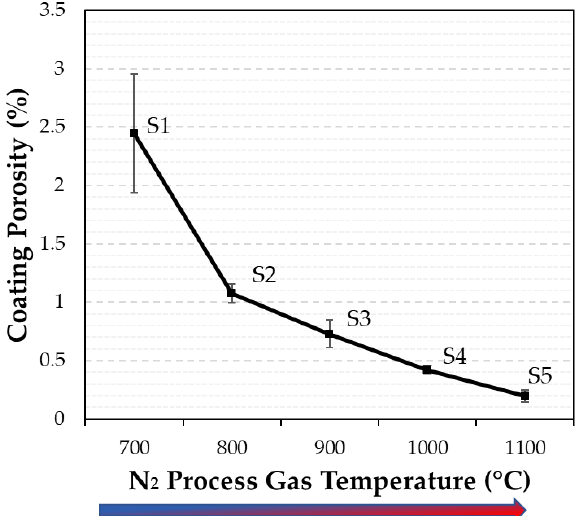
Figure 7. Porosities of the CS Zr coatings (S1–S5) with respect to N 2 process gas temperature (varied between 700−1100 °C).